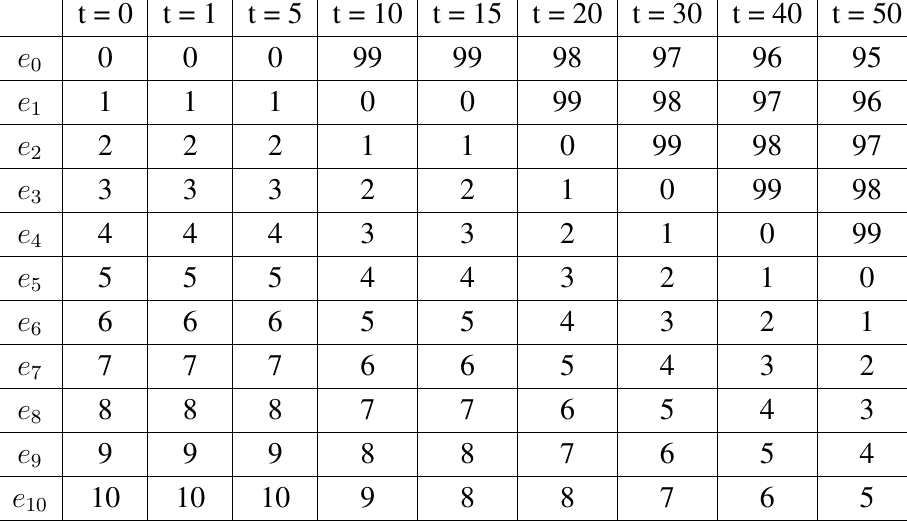
Table 1. Cell selected in function of the event type and time